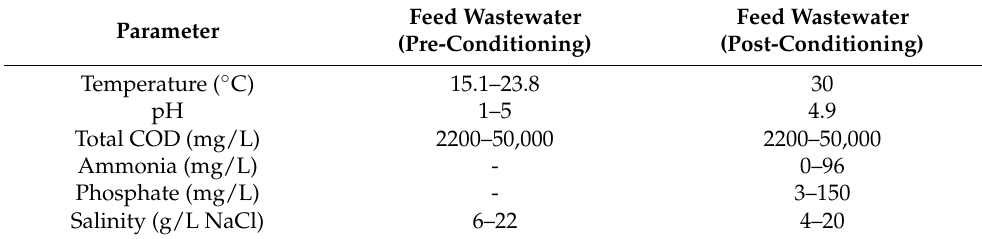
Table 2. Range of parameters of feed wastewater during the testing